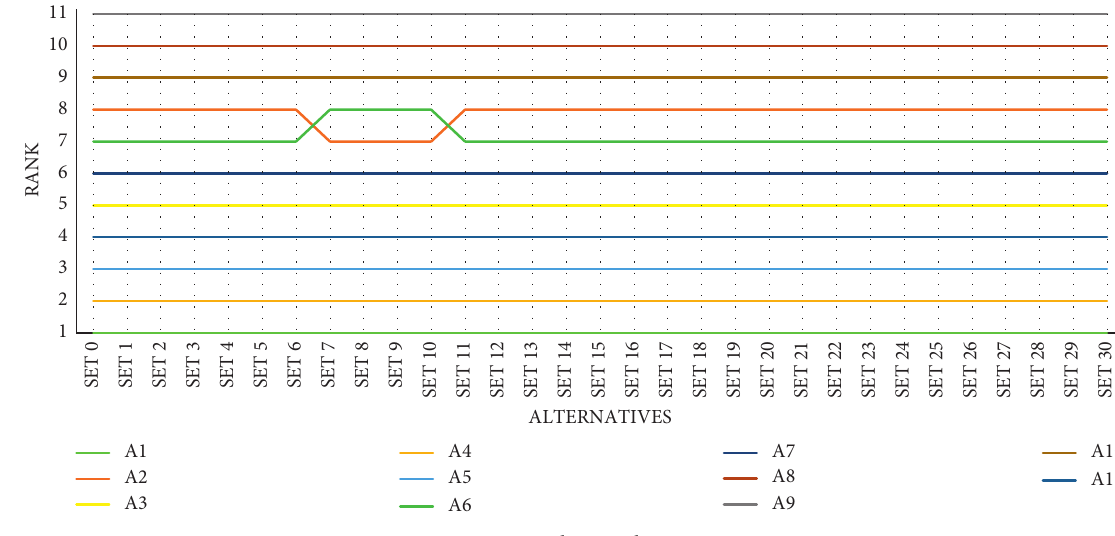
Figure 5: Sensitivity analysis with 30 new scenarios.